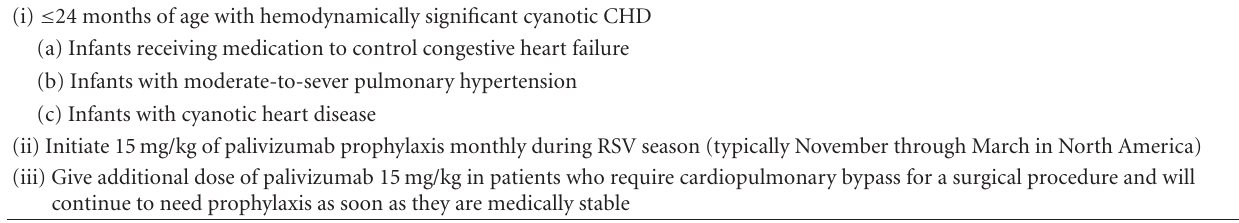
Table 4: Recommendations for palivizumab prophylaxis in children with